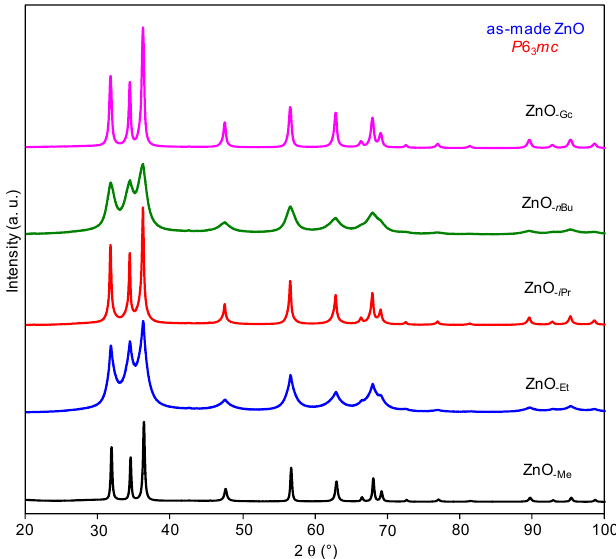
Figure 9 . PXRD patterns of ZnO -R NPs obtained by the direct calcinations of precursors Zn(OR) 2 (R = Me, Et, i Pr, n Bu and Gc) at 500 °C for 4 h.